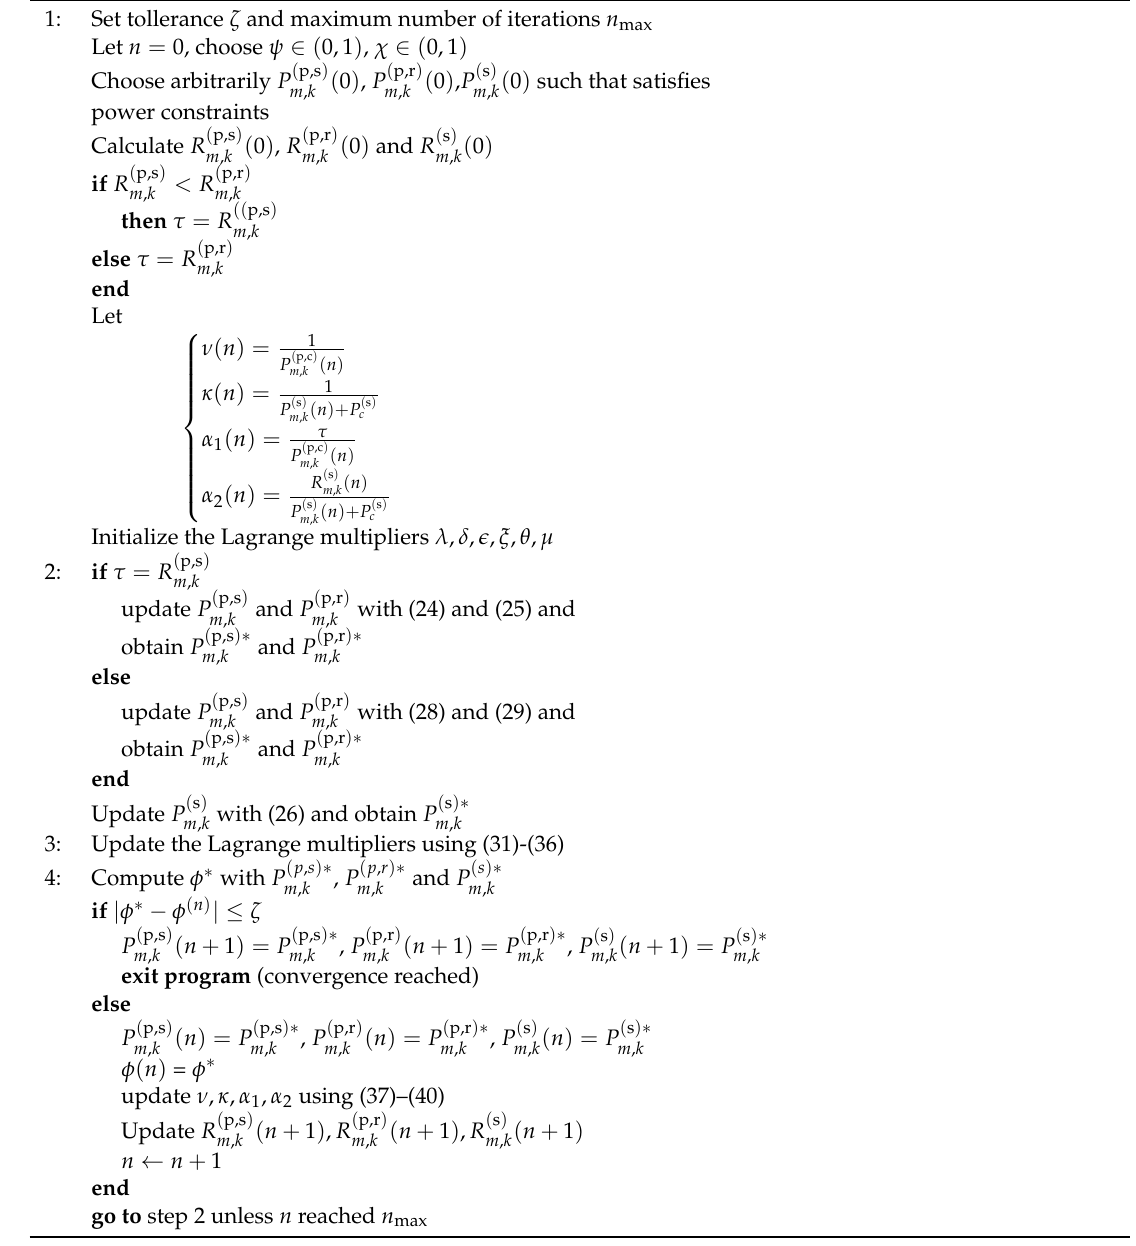
Algorithm 1. Power Allocation